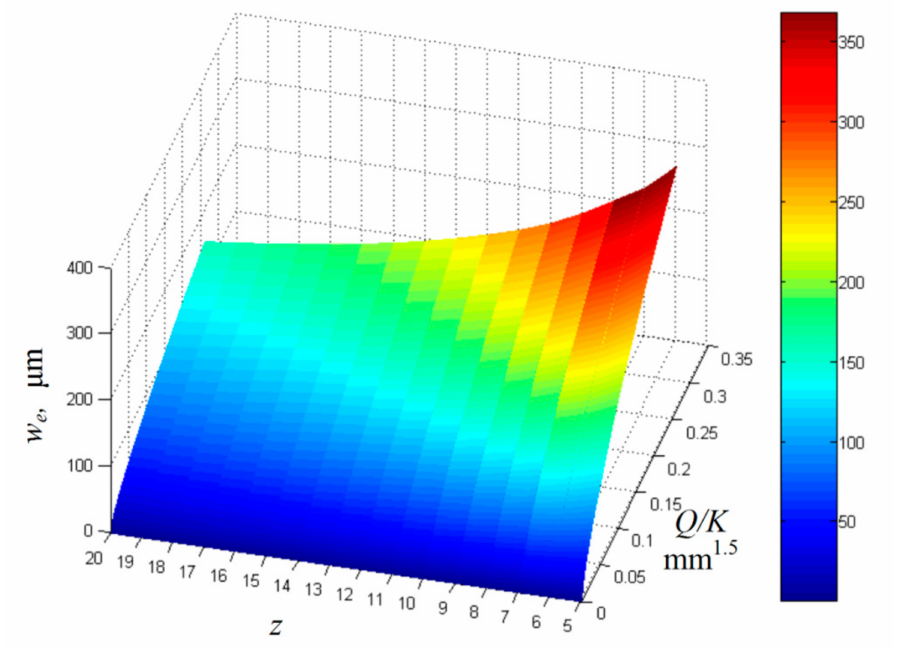
Figure 11. Three-dimensional dependence of bearing deflection ( w e ) on the total number of rolling elements ( z ) and level of external load ( Q ), for the BSE position of rolling